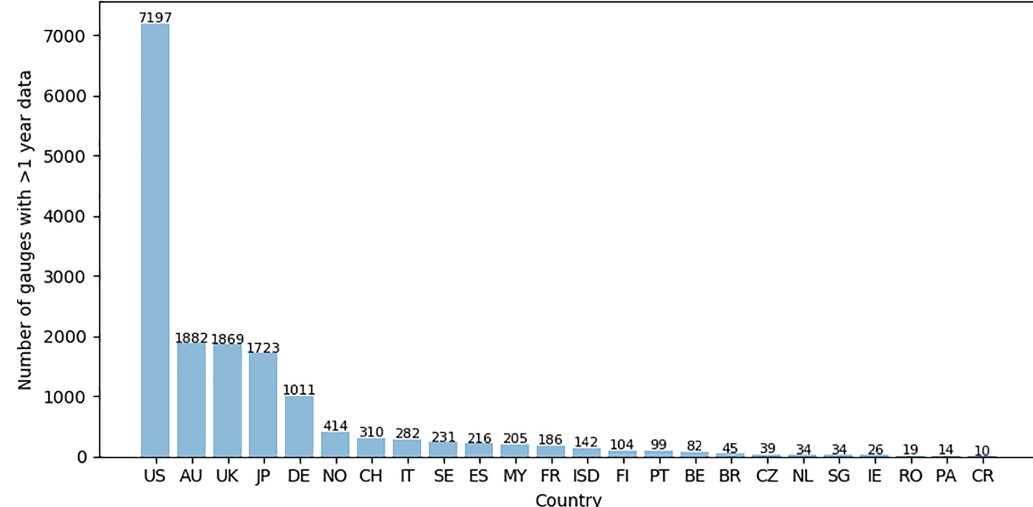
Figure 2. List of countries/data sources contributing at least 10 gauges with a minimum of 1 year of hourly data from the combined data collection exercise and ISD database. Numbers denote the number of gauges. (Abbreviations: US – USA, AU – Australia; UK –